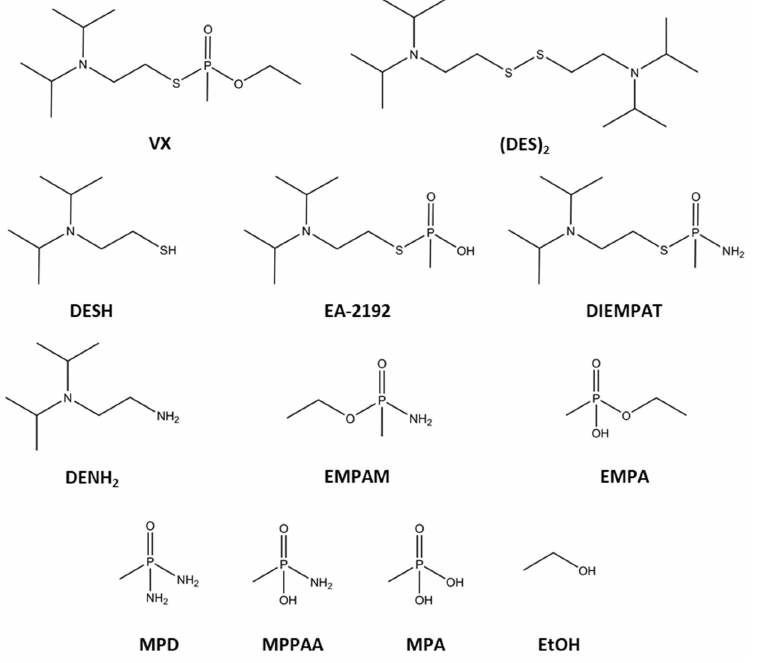
Figure 1. Chemical structure of VX, VX hydrolysis products, and VX ammonolysis products. VX = Ethyl ({2-[bis(propan- 2-yl)amino]ethyl}sulfanyl)(methyl)phosphinate, (DES) 2 = VX Disulfide, DESH = Diisopropylamino ethanethiol, EA-2192 = S-(2-(diisopropylamino)ethyl) O-hydrogen methylphosphonothioate, DIEMPAT = S-(2-(diisopropylamino)ethyl) P-methyl phosphonamidothioate, DENH 2 = N,N-Diisopropylethylenediamine, EMPAM = Ethyl P-methyl phosphonamidite, EMPA = Ethyl methylphosphonic acid, MPD = P-Methylphosphonic diamide, MPPAA = P-methylphosphonamidic acid, MPA = Methylphosphonic acid, EtOH = Ethanol.